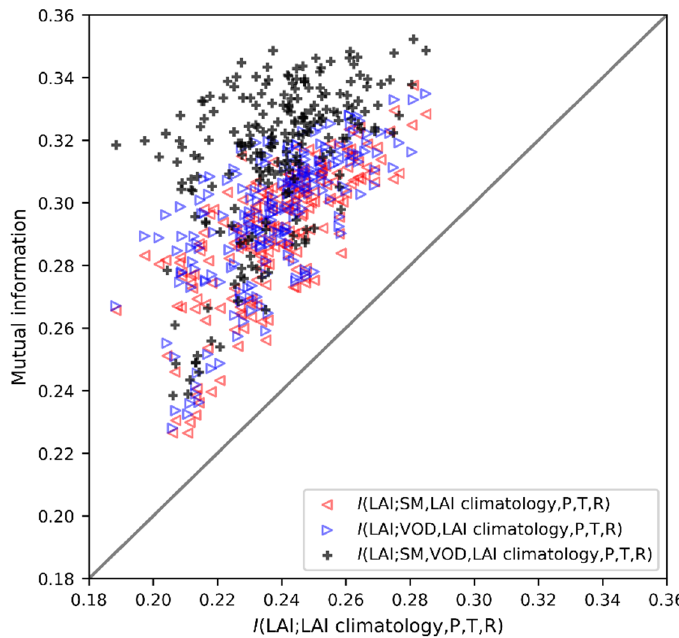
Figure 2. Mutual information between LAI and LAI climatology (LAI C ), precipitation (P), tempera- ture (T) and radiation (R) (based predictors) against the mutual information between LAI and soil moisture (SM) and base predictors (red triangles), the mutual information between LAI and VOD and base predictors (blue triangles), and mutual information between LAI and base predictors and VOD and SM (black crosses).